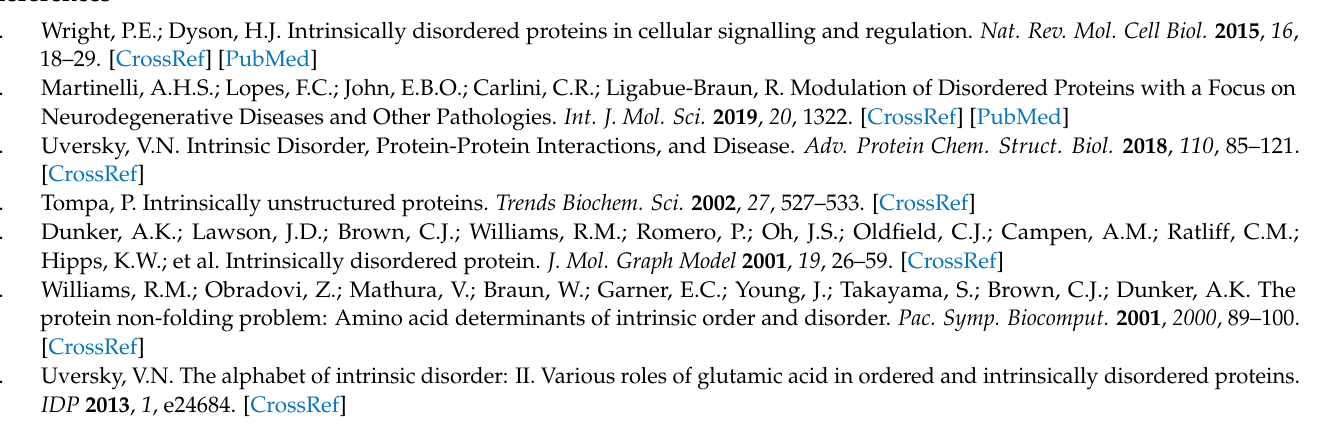
S7: Helix formation time series; Figure S8: Helix population simulations; Figure S9: Salt bridge frequency